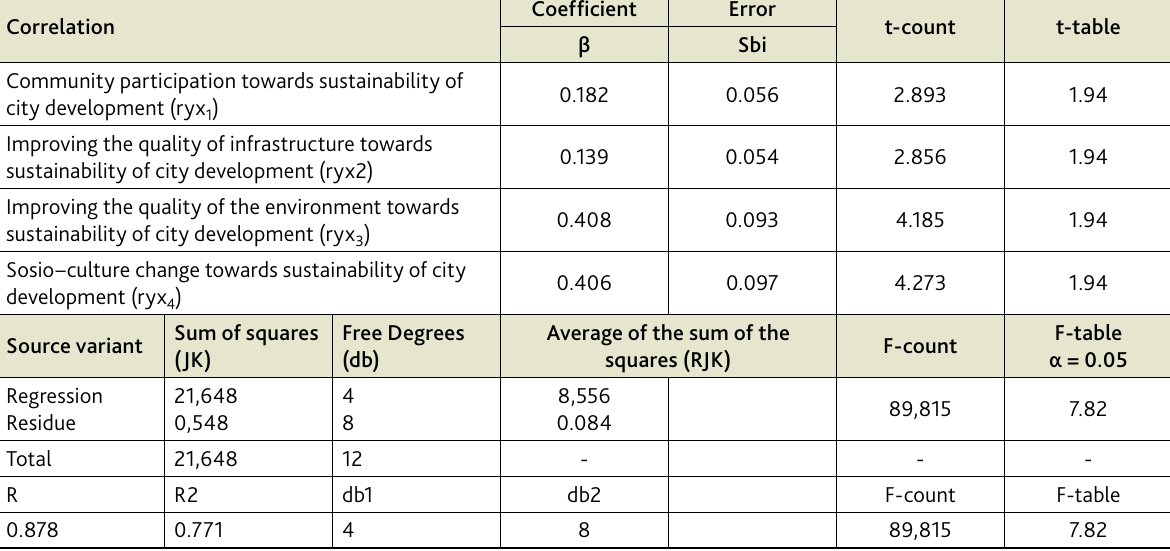
Table 2. Summary of test results for the significance of multiple regression coefficients